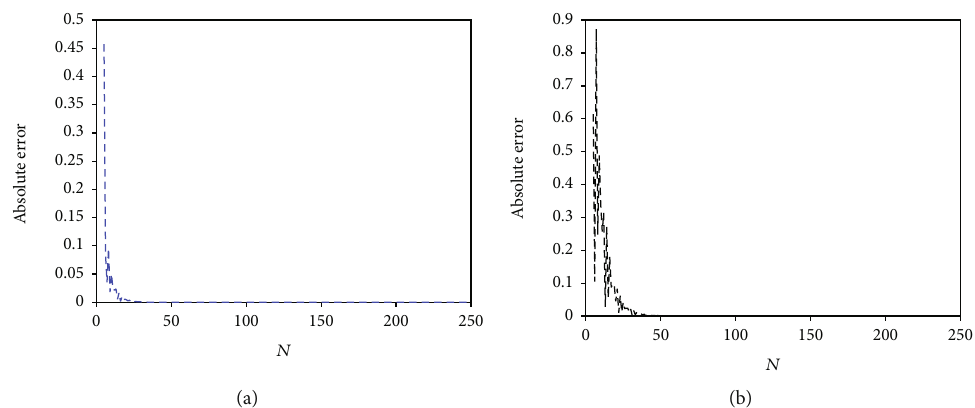
is shown. In (b), the absolute error 1